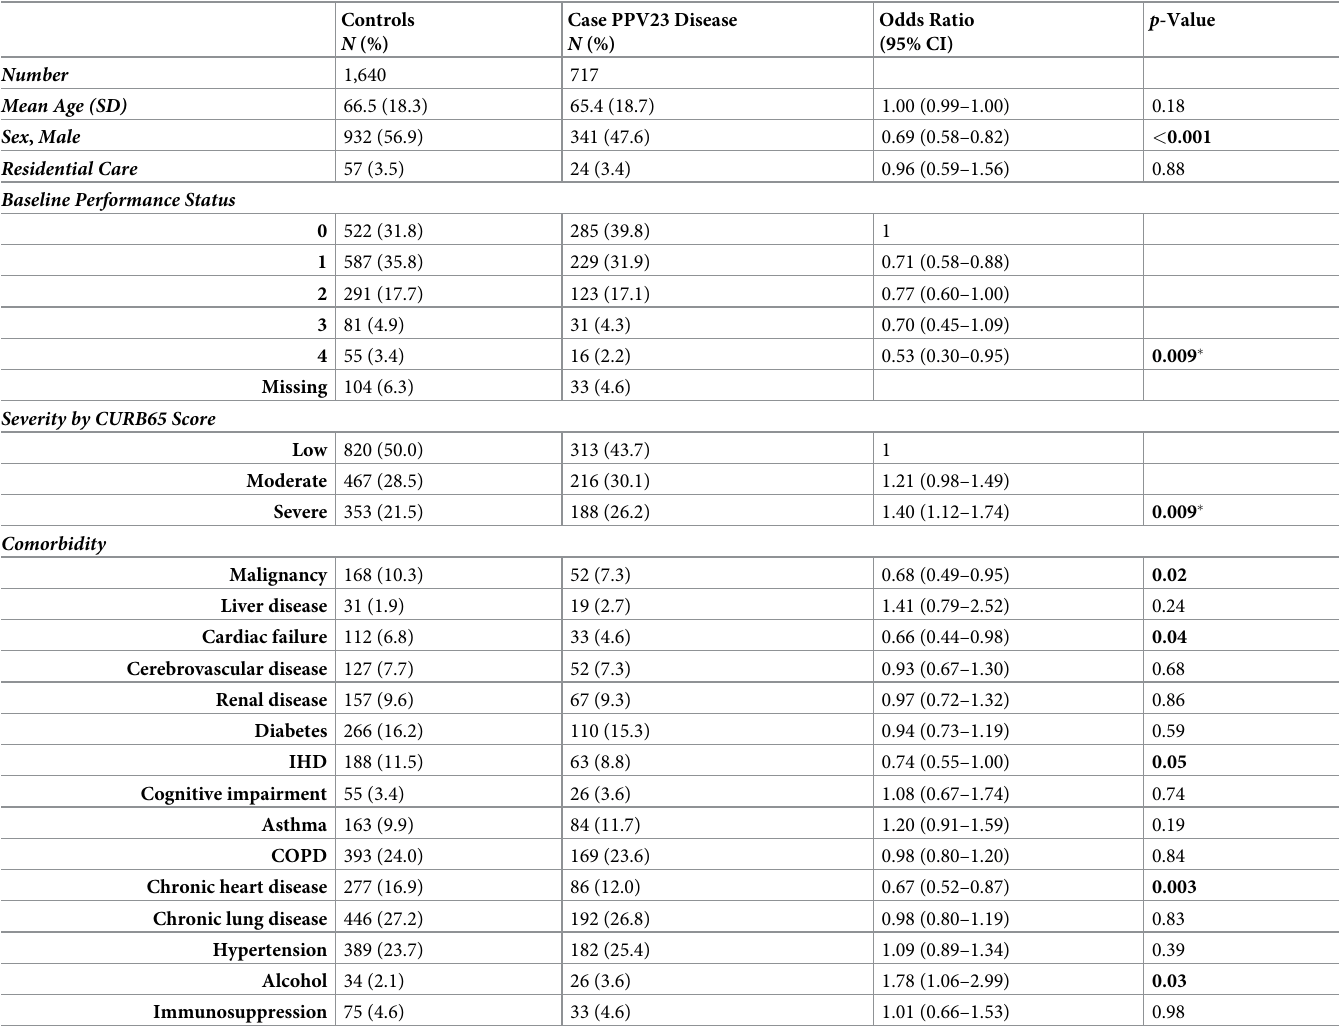
Table 1. Characteristics of cases and control groups for the primary